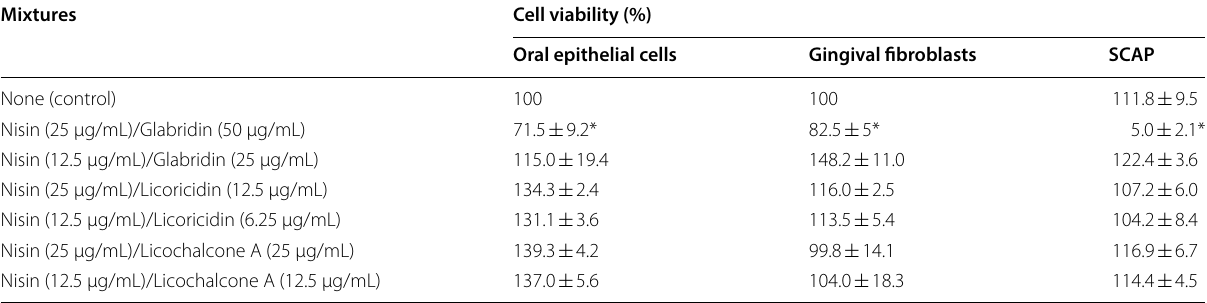
*Significant decrease ( p < 0.01) compared to untreated control cell